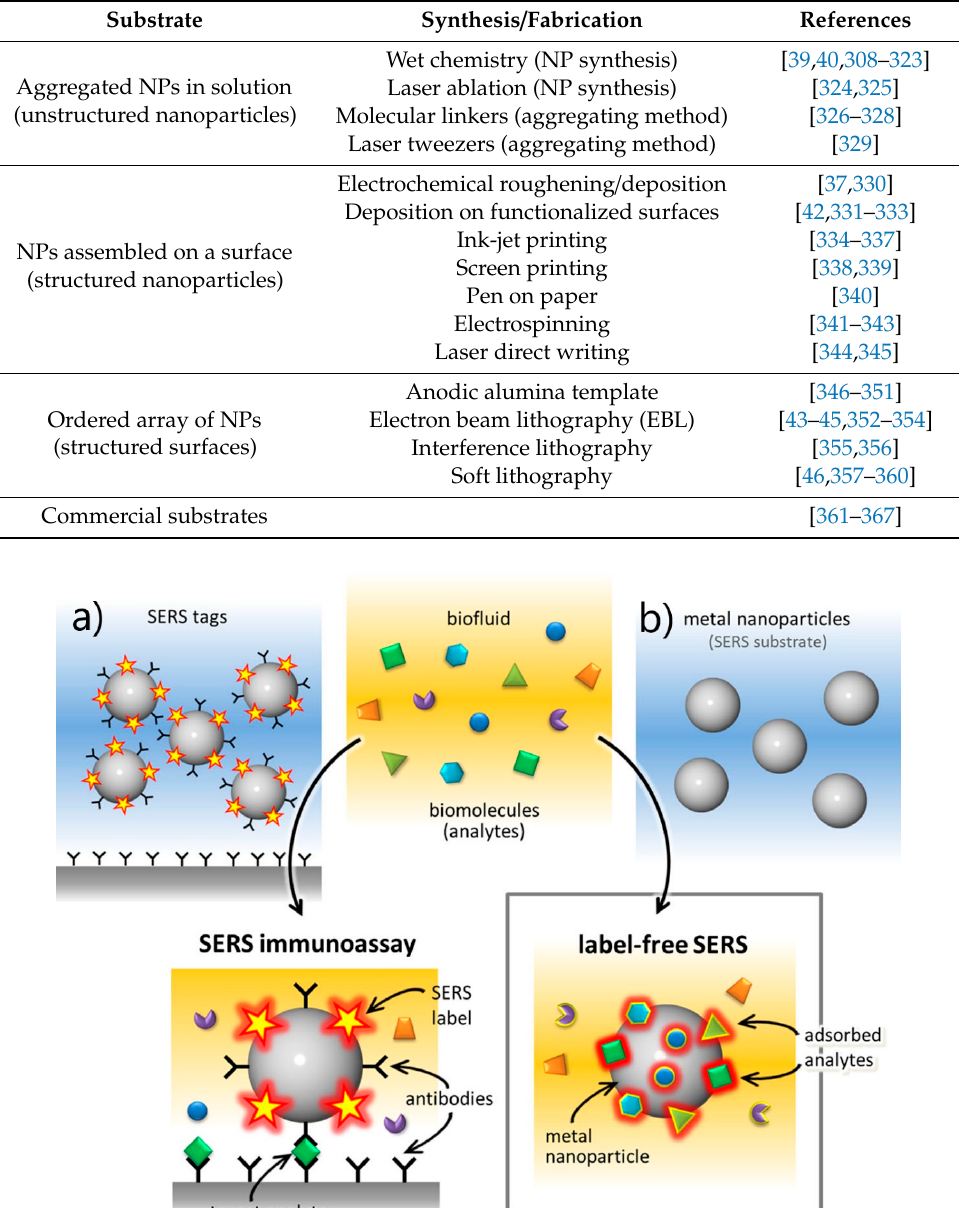
Table 7. Summary of the substrates and of the corresponding fabrication methods presented in this section.